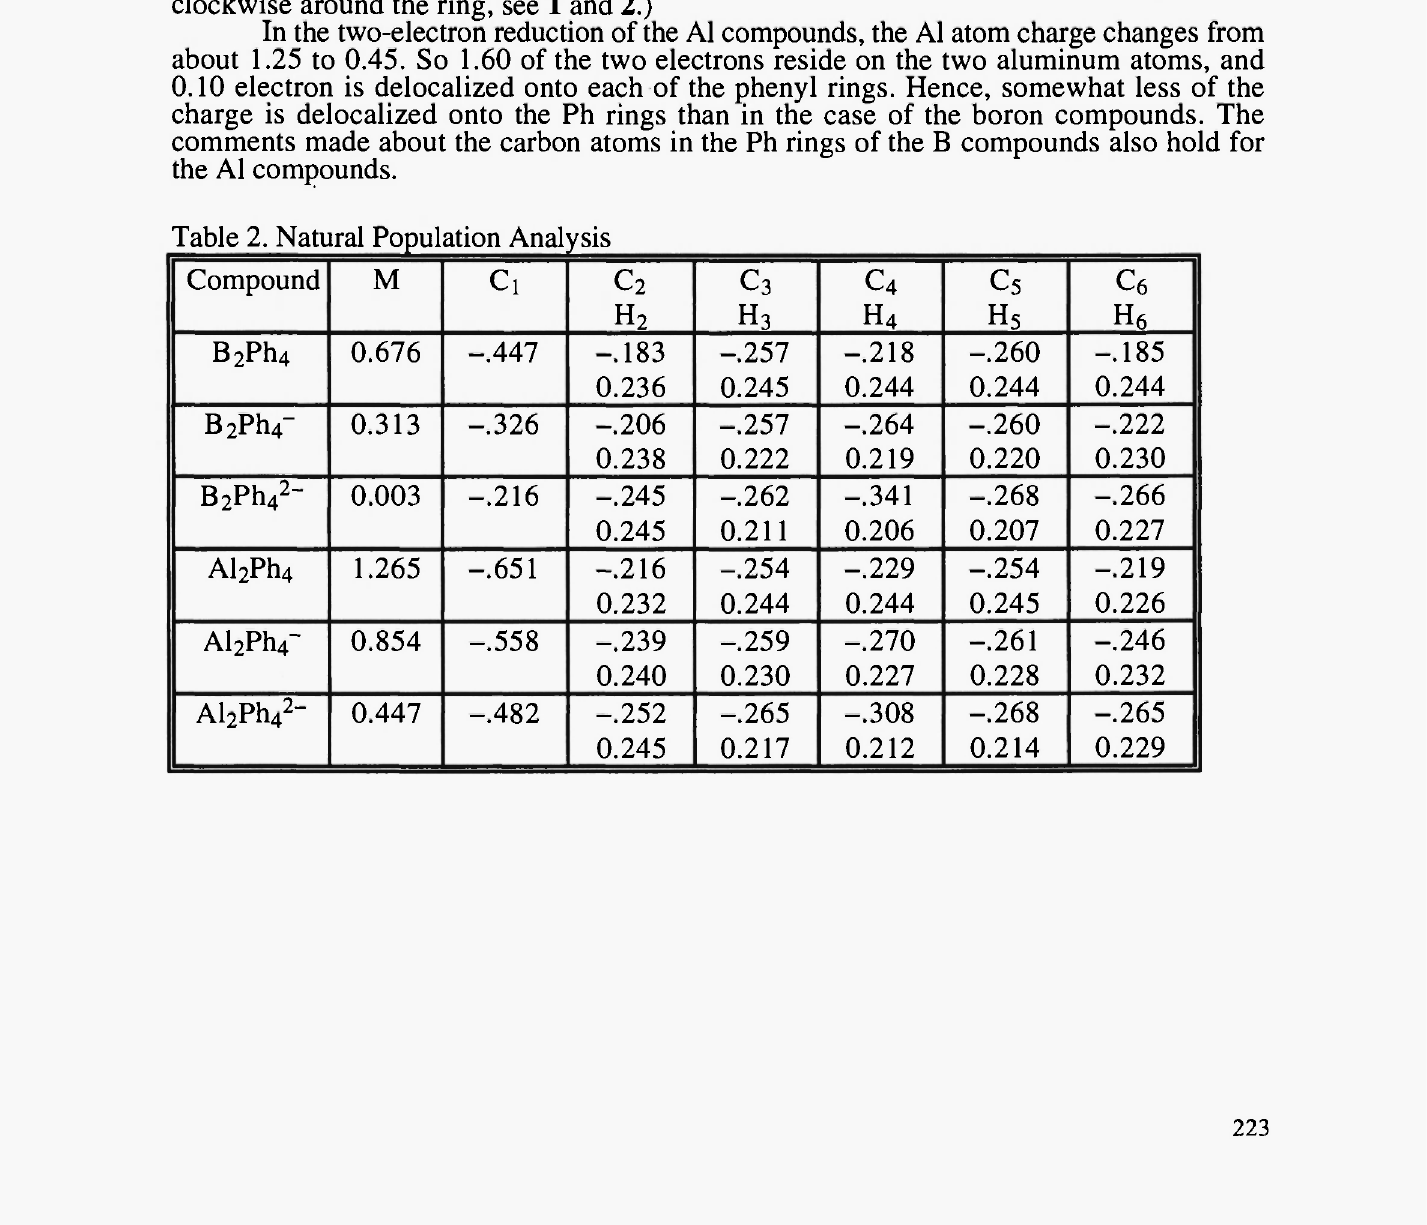
Table 2. Natural Population Analysis